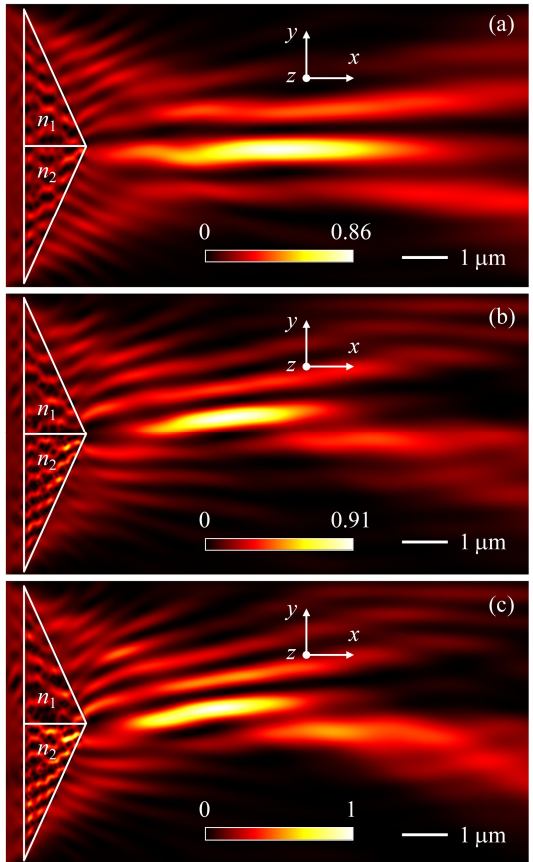
Figure 4. Normalized intensity distributions of the photonic hooks formed by triangular Janus micro-prisms at n 1 = 1.5, ( a ) n 2 = 1.58, ( b ) n 2 = 1.88, and ( c ) n 2 = 1.95. The height and width of triangular Janus micro-prisms are h = 1.5 μ m and w = 3 μ m.